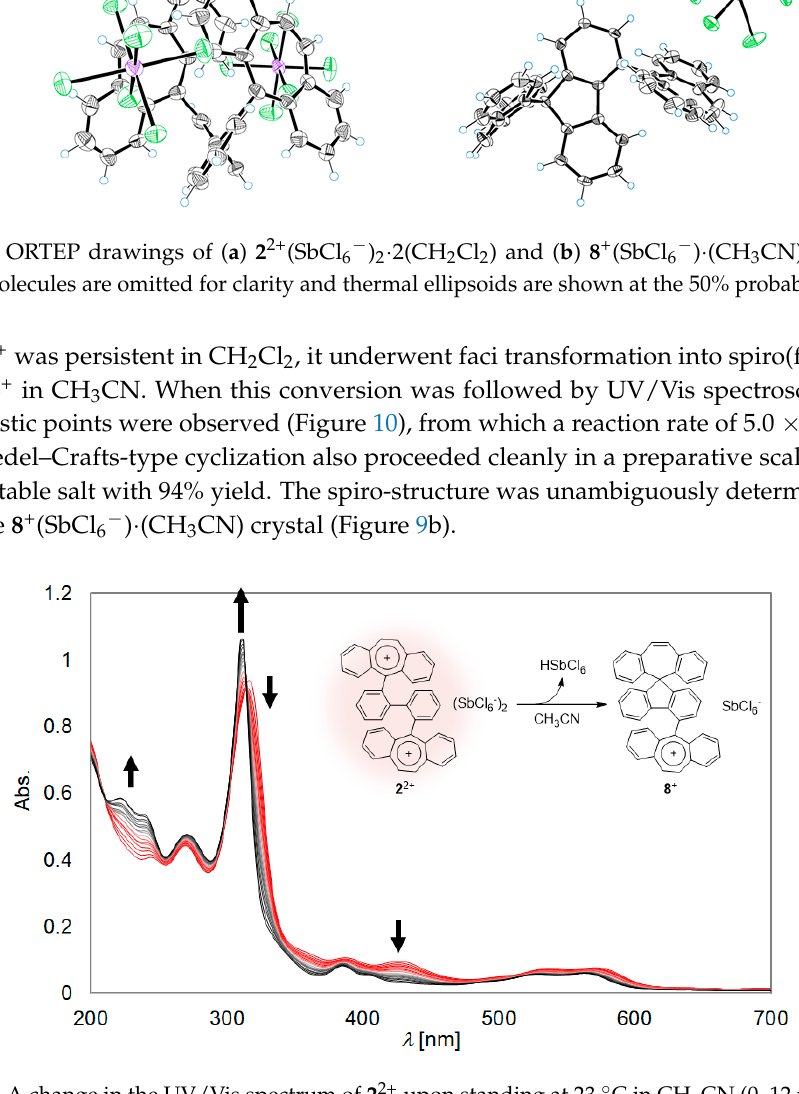
Figure 10. A change in the UV/Vis spectrum of 2 2+ upon standing at 23 °C in CH 3 CN (0–12 min, every 2 min; 12–36 min, every 4 min; 36–52 min, every 8 min; 52–84 min, every 16 min).